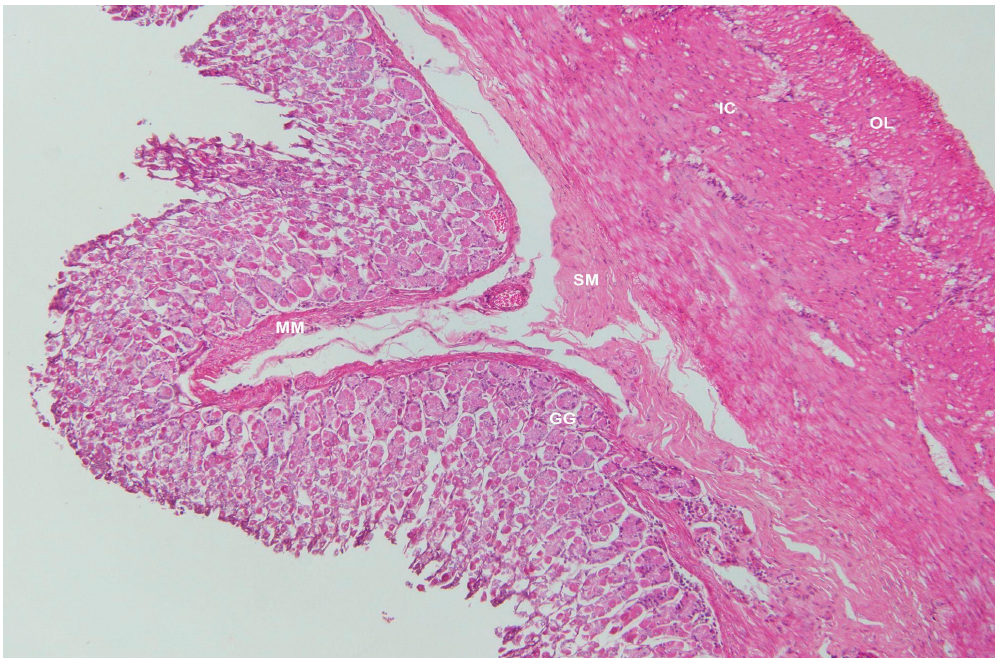
Figure 8. Photomicrograph of a transverse section through the pyloric region of an adult male D. leporina . H&Ex200. GG—gastric glands; MM—muscularis mucosa; SM—submucosa; IC—inner circular layer; OL—outer longitudinal layer.